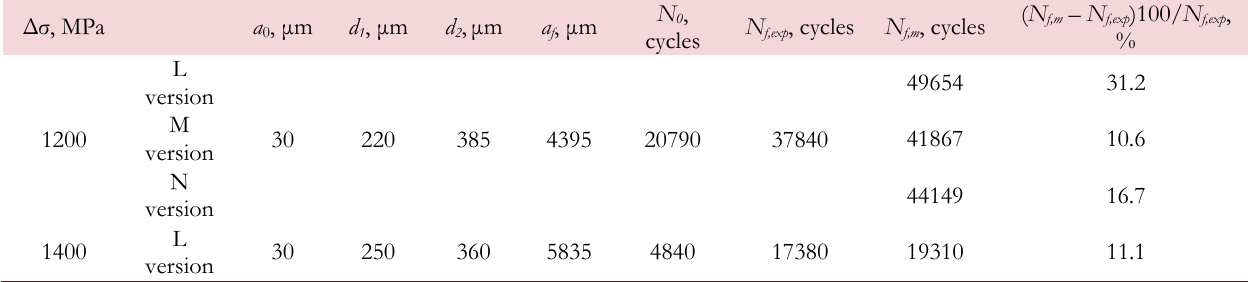
Table 2: Fatigue characteristics of Steel A for MSC, PSC, LC growth and some numbers of cycles during specimen fatigue